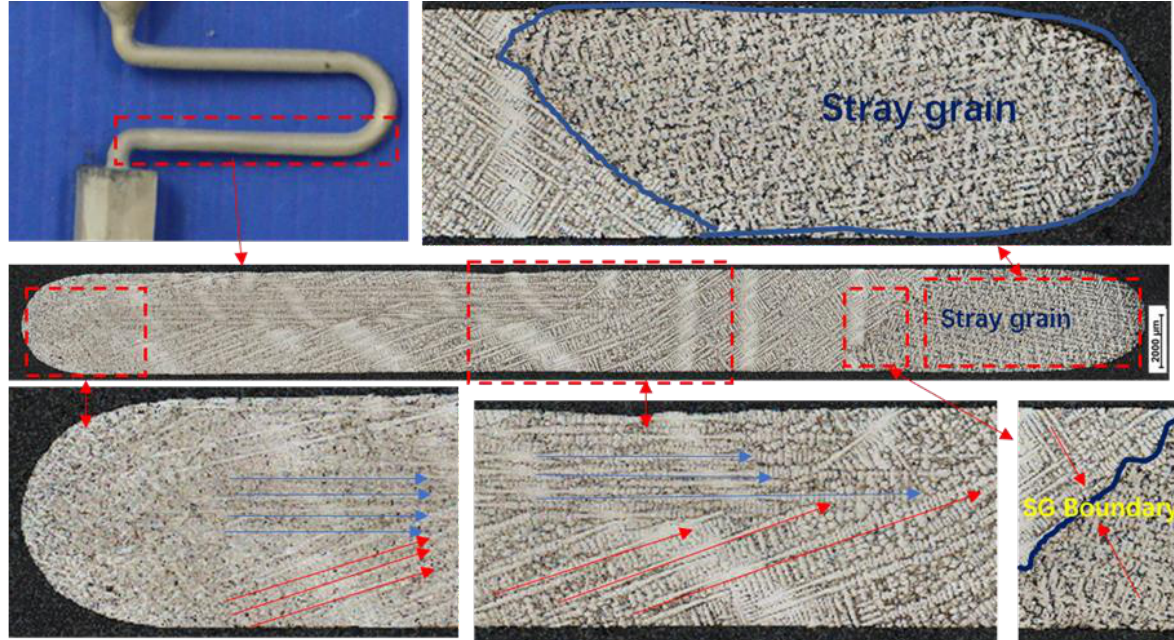
Figure 3. ( a ) Grain growth direction in the cross selection of the grain selector; ( b ) grain boundary Figure 3. Grain growth direction in the cross selection of the grain element distribution of the alloys.